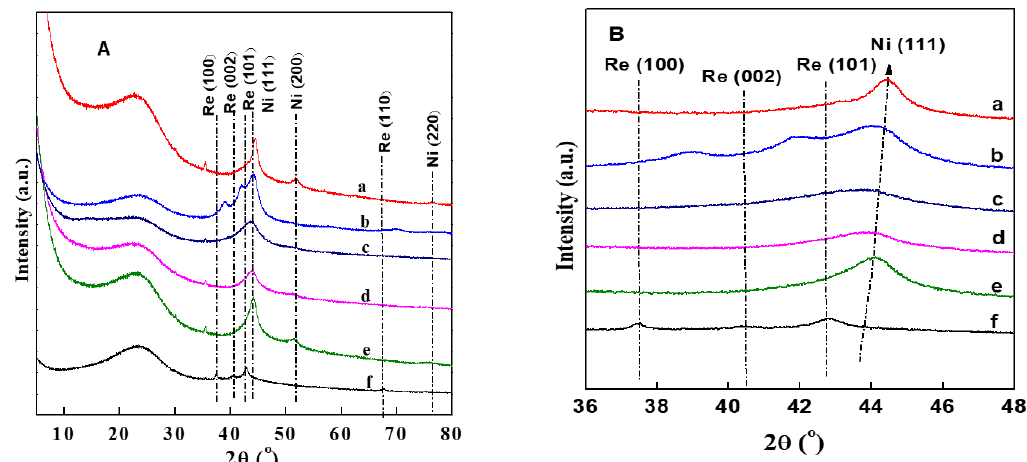
Figure 1. XRD patterns of ( A ) (a) Ni / activated carbon (AC), (b) Ni-Re / AC(n Ni :n Re = 1:1), (c) Ni-Re / AC(n Ni :n Re = 2:1), (d) Ni-Re / AC(n Ni :n Re = 4:1), (e) Ni-Re / AC(n Ni :n Re = 10:1), and (f) Re / AC. ( B ) Magnification of (A).